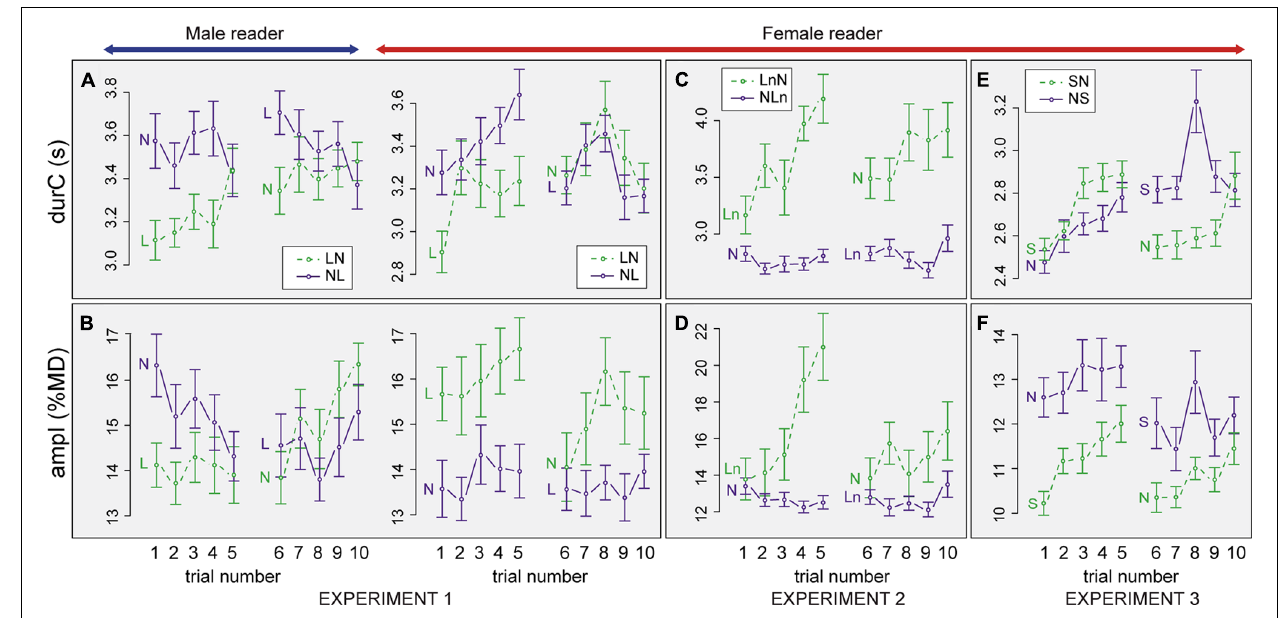
FIGURE 4 | Progression of listener inhalation amplitude and breathing cycle duration (mean ± 1 standard error) from trial 1 to 10. Data are split by experiment (Experiments 1, 2, and 3), condition ( N : Normal, L : Loud, Ln Loud played with normal volume, S : Slow), and Order (e.g., NL : Normal-Loud). Results for duration (A,C,E) , amplitude (B,D,F) , Experiment 1 (A,B) , Experiment 2 (C,D) , Experiment 3 (E,F)